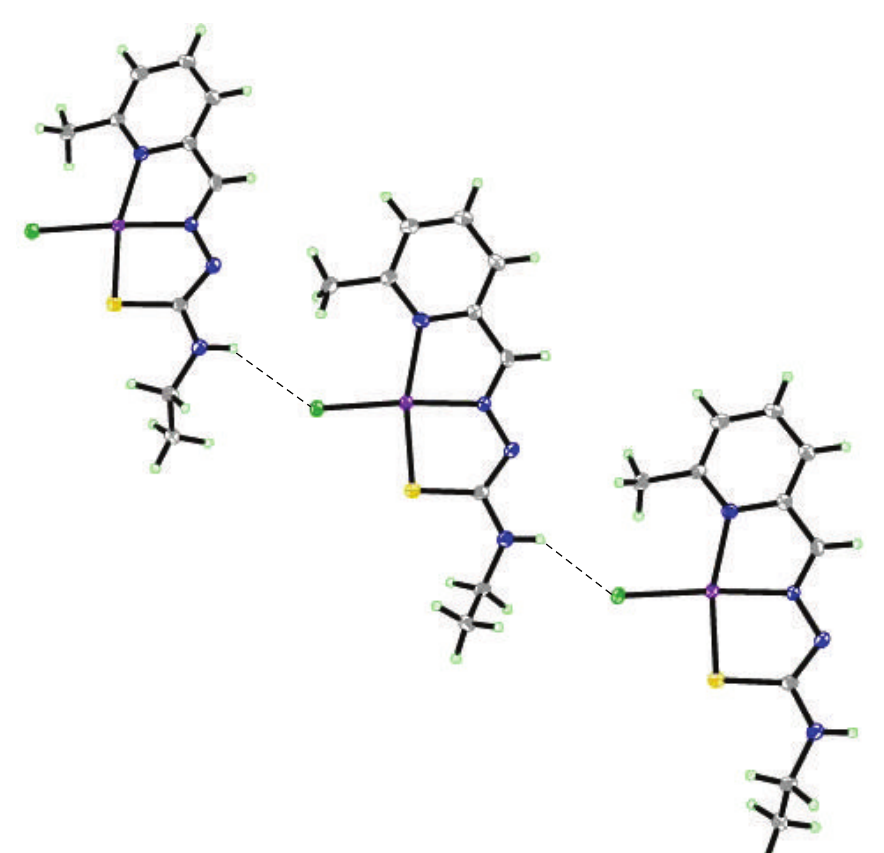
Figure 5: Hydrogen bonding interaction in the lattice of [Pt(mpETSC)Cl].